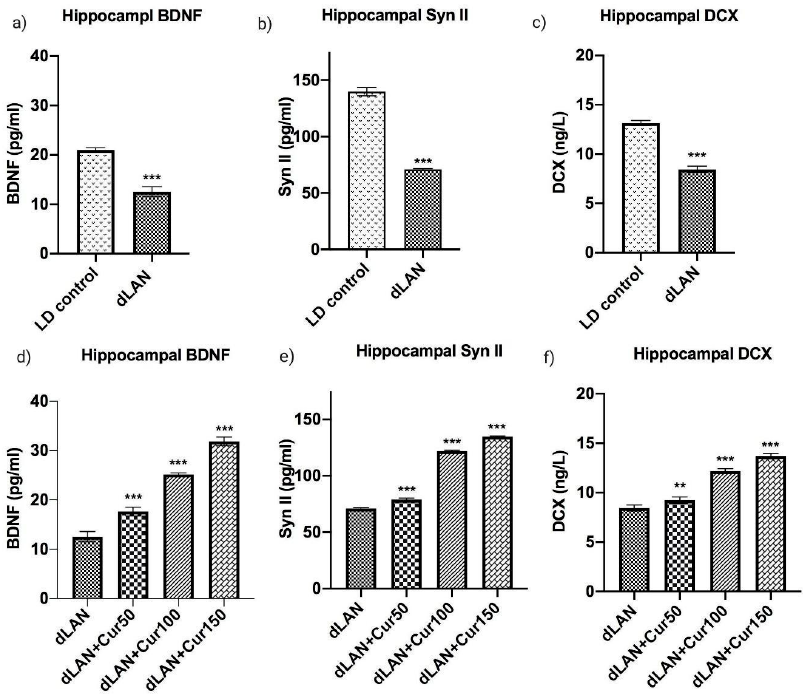
Figure 4. Effect of curcumin on dLAN altered hippocampal proteins ( a , d ) BDNF, ( b , e ) Synapsin II, and ( c , f ) DCX. Values are represented as mean ± standard deviation. The t- test was employed to